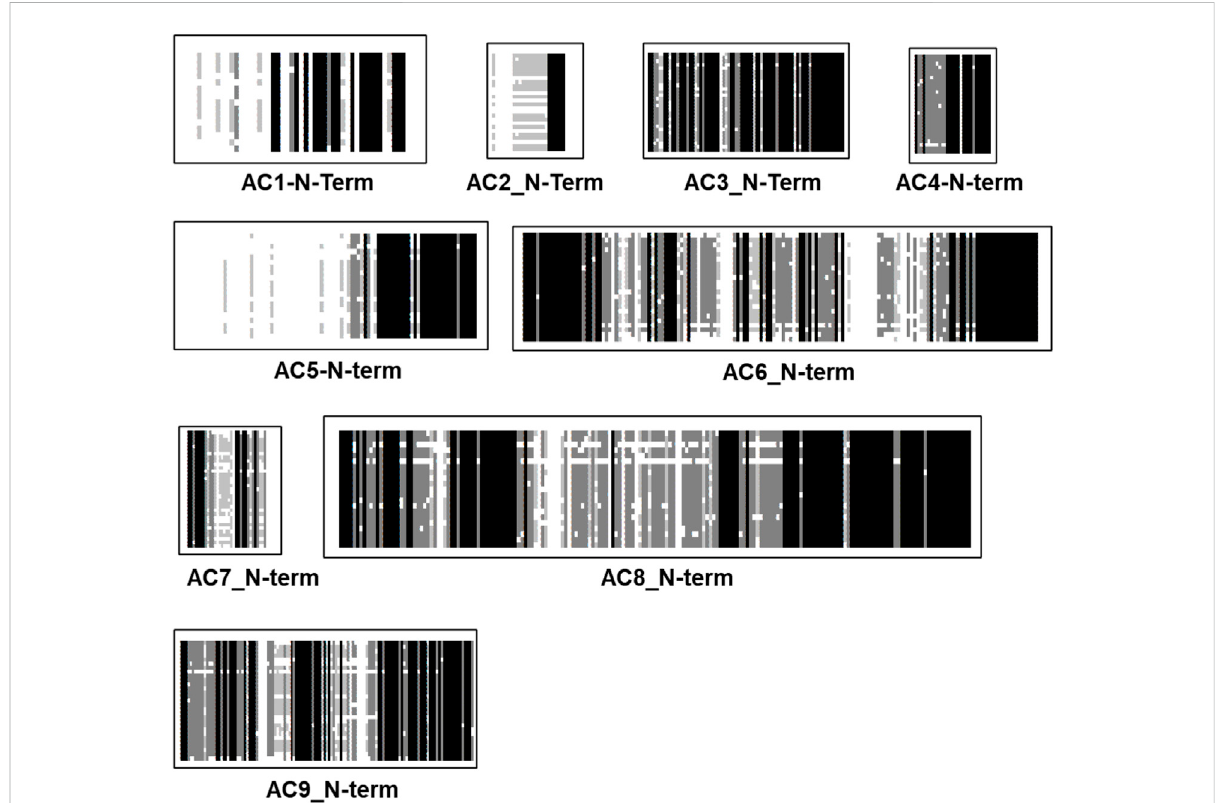
FIGURE 4 Alignment of N-termini of the nine mammalian mAC isoforms. mAC1: 19 isoforms were used, the N-terminus is 50 aa – 60 aa long; mAC2: 27 isoforms; N-terminus rather variable between 6 aaand 50 aa. mAC3: 29 isoforms, length (77 aa) and sequence conserved. mAC4: 28 isoforms, length (28) and sequence conserved. mAC5: 28 isoforms of variable length (50 aa – 240 aa); mAC6: 29 isoforms with an invariant 148 aa long, highly conservedN-terminus;mAC7:34isoforms,invariantlyof33wellconservedaa ’ s;mAC8:29isoforms,highlyconservedlengthof180 aa.mAC9: 34 isoforms, uniform length of 120 highly conserved aa. Note the invariant region prior to TM1 in all isoforms except AC7. Shading: black, invariant; dark grey, conserved; light grey, slightly conserved; white: